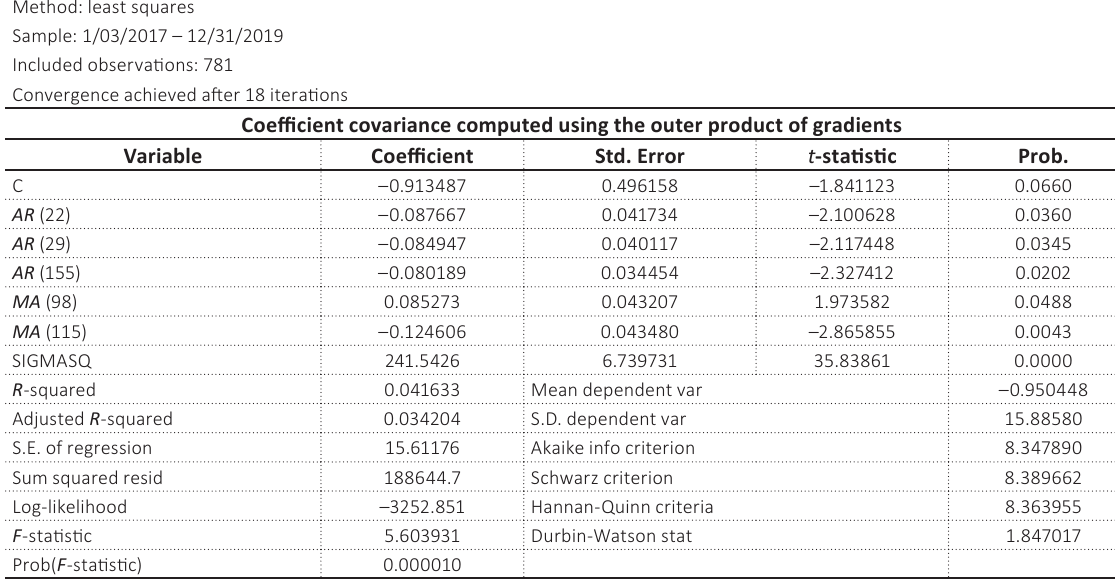
Table 7. Results of best 5 ARIMA models out of 144 models for Dr. Reddy’s Laboratories ARIMA ( p , d , q ) AIC (Akaike Information